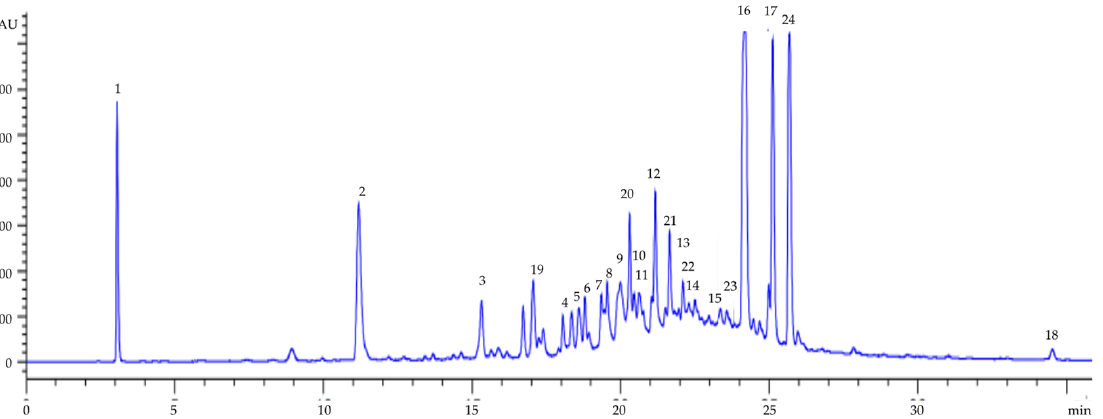
Figure 4. HPLC chromatogram of phenolic compounds from UAE extract of Annona muricata leaves. (1) shikimic acid, (2) gallic acid, (3) protocatechuic acid, (4) neochlorogenic acid, (5) 3,4 ‐ dihydroxy ‐ phenylacetic, (6) 4 ‐ hydroxybenzoic acid, (7) chlorogenic acid, (8) 4 ‐ hydroxyphenyl acetic, (9) vanillic acid, (10) syringic acid, (11) 3 ‐ hydroxybenzoic acid, (12) caffeic acid, (13) 4 ‐ hydroxybenzaldehyde, (14) homovanillic acid, (15) 3 ‐ (4 ‐ hydroxyphenyl), 916) ‐ coumaric acid, (17) trans ‐ ferulic acid, (18) trans ‐ cinnamic acid, (19) gallocatechin, (20) epigallocatechin, (21) catechin, (22) epicatechin, (23) ru ‐ tin, (24) ellagic acid. Table 4. Phenolic compounds profile from extracts of Annona muricata leaves obtained by optimal conditions of ultrasound ‐ assisted extraction (UAE), decoction, and infusion.